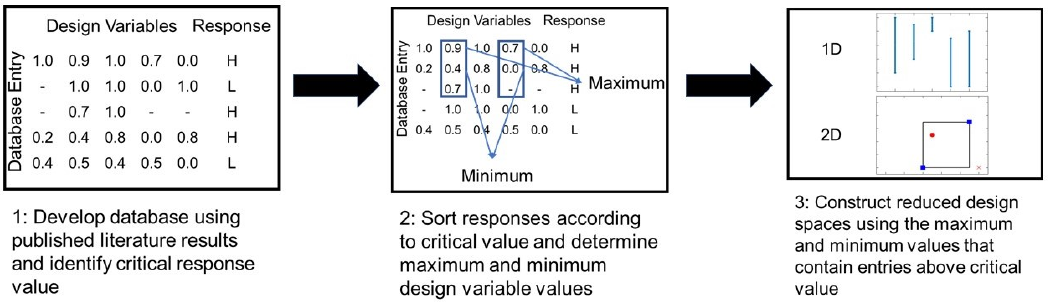
Figure 1. Flow chart of classification approach to constructed reduced design regions.